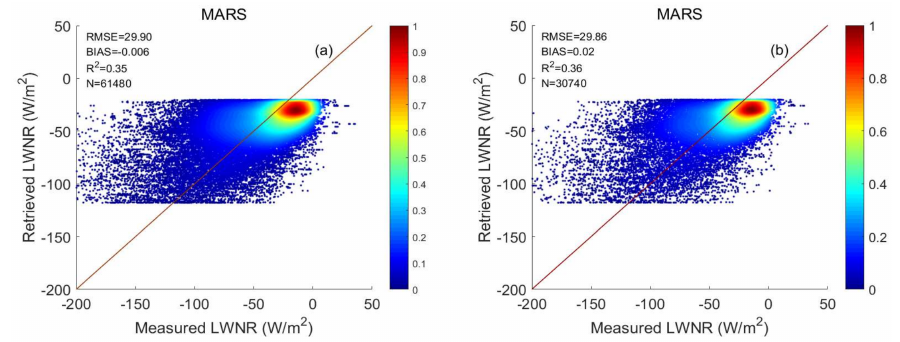
Figure 5. Accuracy of the multivariate adaptive regression spline (MARS) model: ( a ) training results and ( b ) validation results.